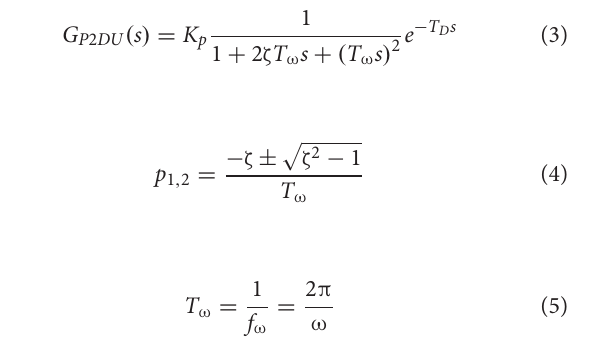
be rewritten in the form of a second-order polynomial, based on